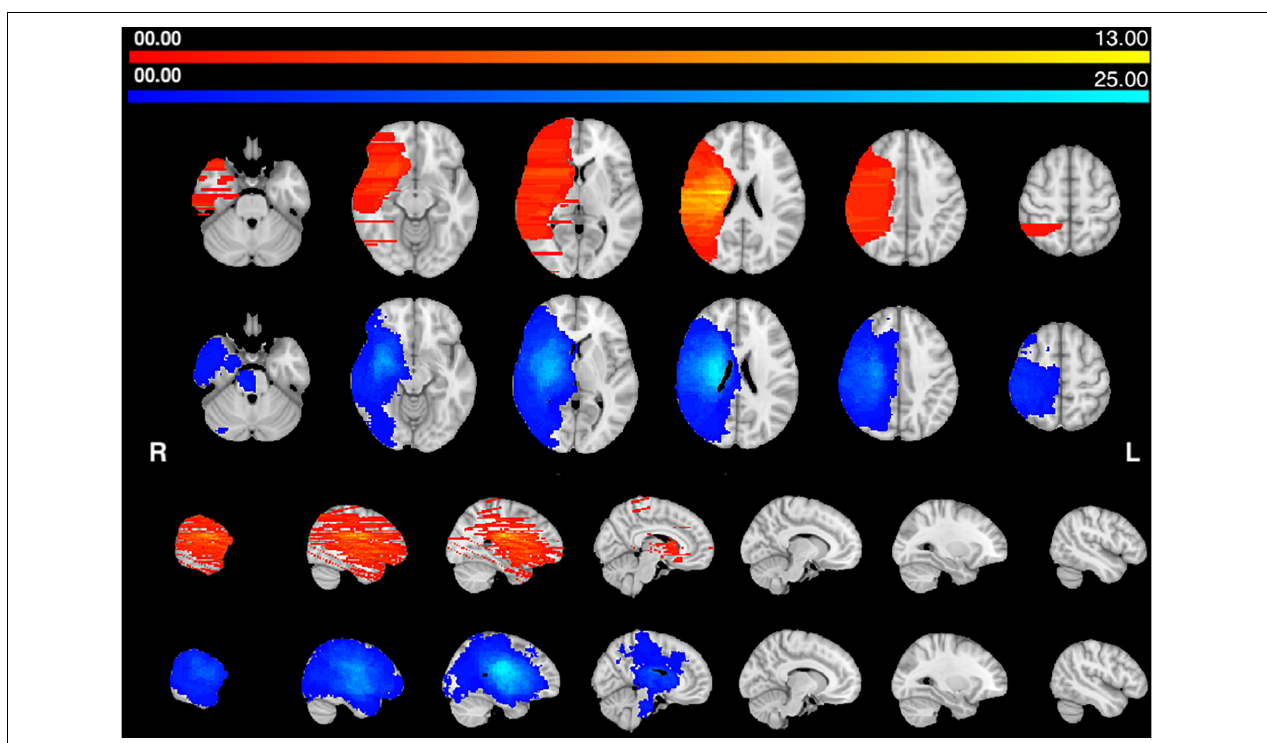
FIGURE 1 | Lesions frequency map: Voxel lesion overlap in AHP (orange-yellow) and HP groups (blue-teal). The color scale indicates the max number of patients with lesions in one